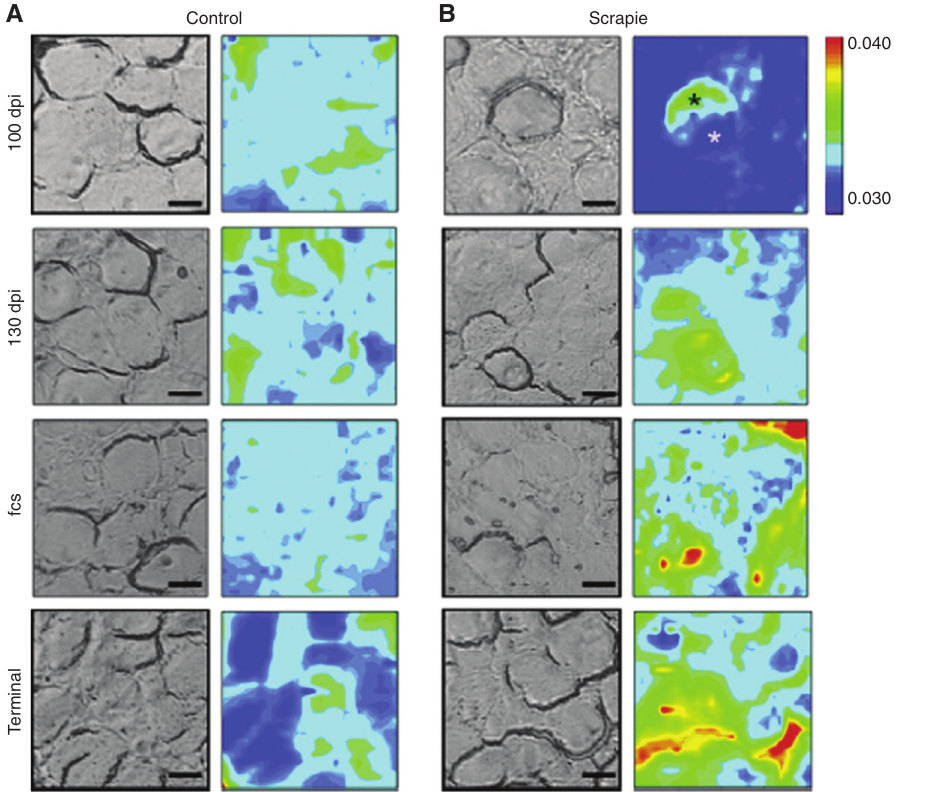
Figure 2 Synchrotron-FTIR analysis of prion disease. Chemical maps showing the β -sheet content in ganglia of Syrian hamster during scrapie progression. Ganglia from uninfected controls (A) and infected (B) hamsters are illustrated. Images of unlabeled frozen sections (left panels) and corresponding chemical maps showing the β -sheet/ α -helix ratio (right panels) were obtained at 100 and 130 days post infection (dpi), at time of first clinical signs (fcs), and at terminal stage. The β -sheet/ α -helix ratio is represented by a color scale going from red (highest) to blue (lowest or nil). Scale bar, 20 μ m. Reproduced and adapted from Kretlow et al. (2008). White asterisk shows that at 100 dpi spectrum is essentially α -helical in most cells; black asterisk identifies area near cell membrane with higher β -sheet